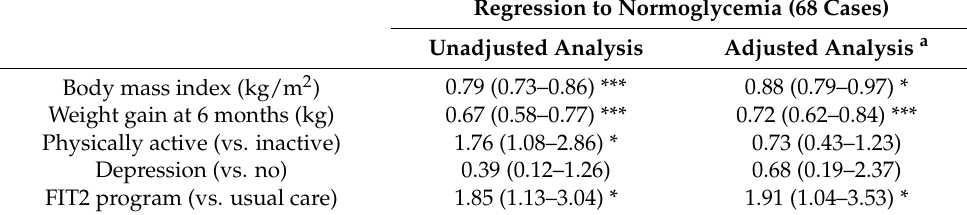
Table 1. Factors for long-term glycemic outcomes among prediabetic smokers in the intention-to- treat analysis ( n = 589).